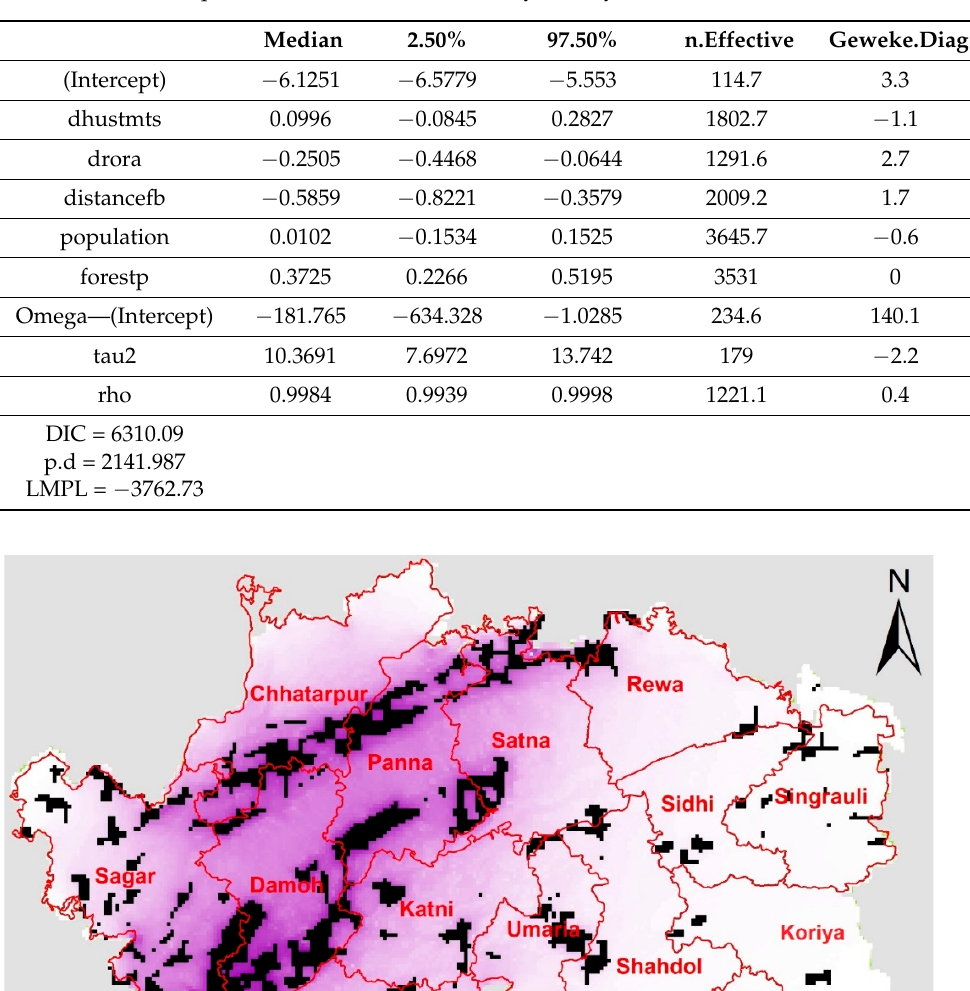
Table A2. Posterior quantities and DIC of the CARBayes analysis.